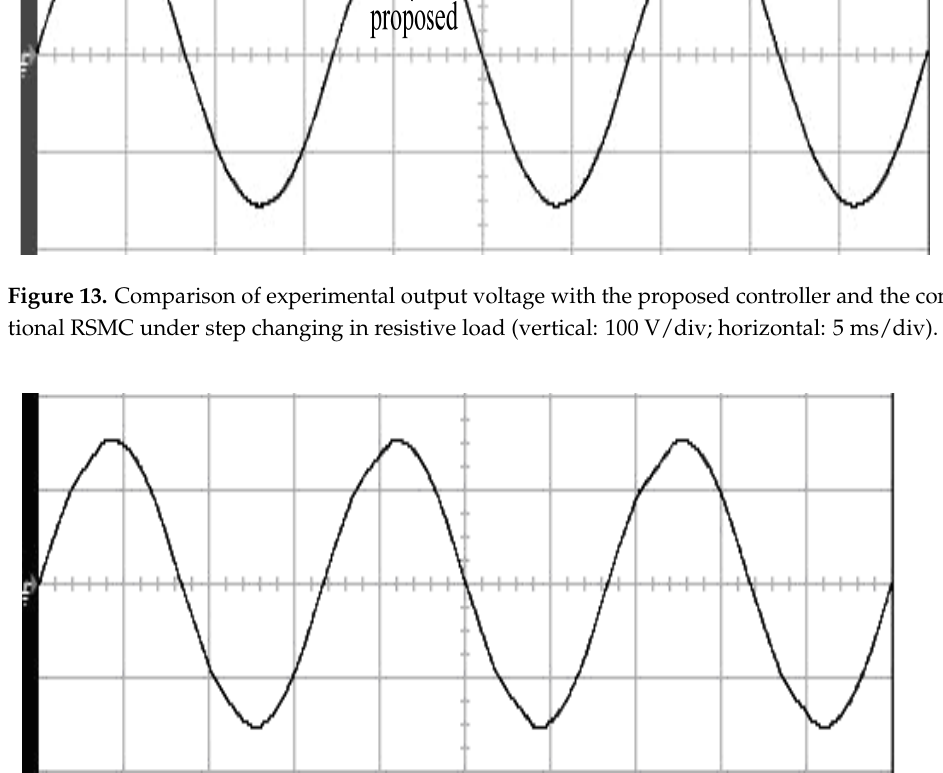
100 V/div; horizontal: 5 ms/div).